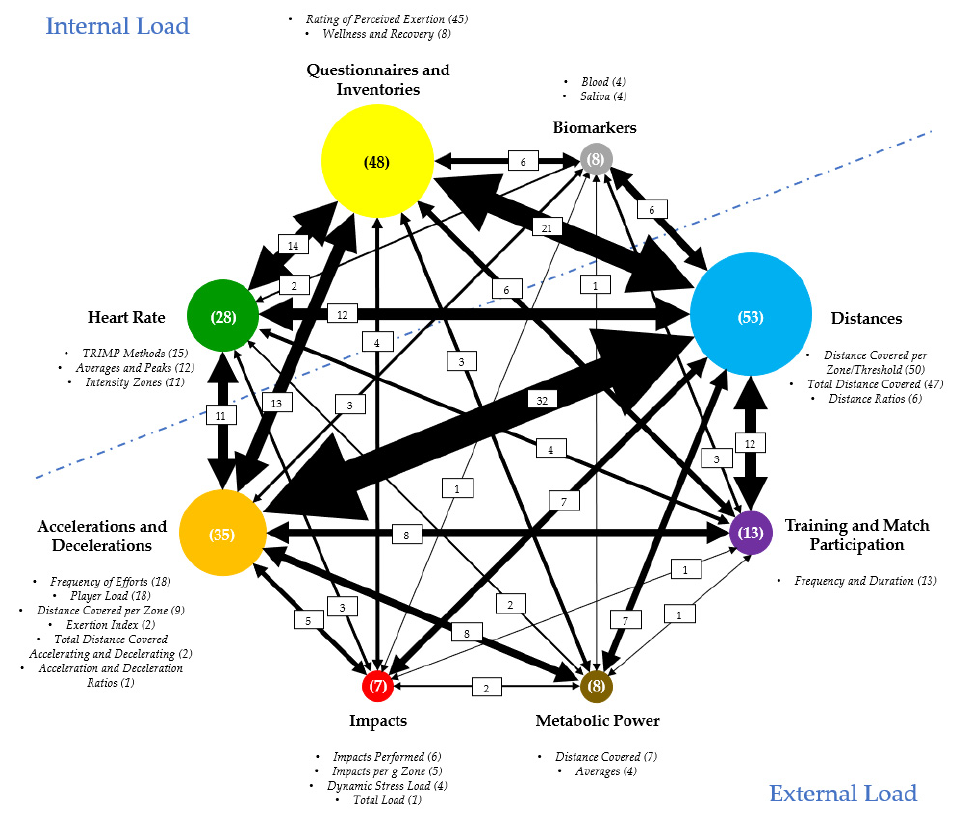
Figure 2. Load measures groups: quantities and relationships.